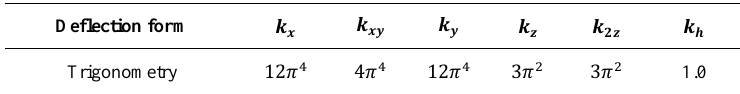
Table 1. Trigonometric form of stiffness coefficients of CCCC rectangular